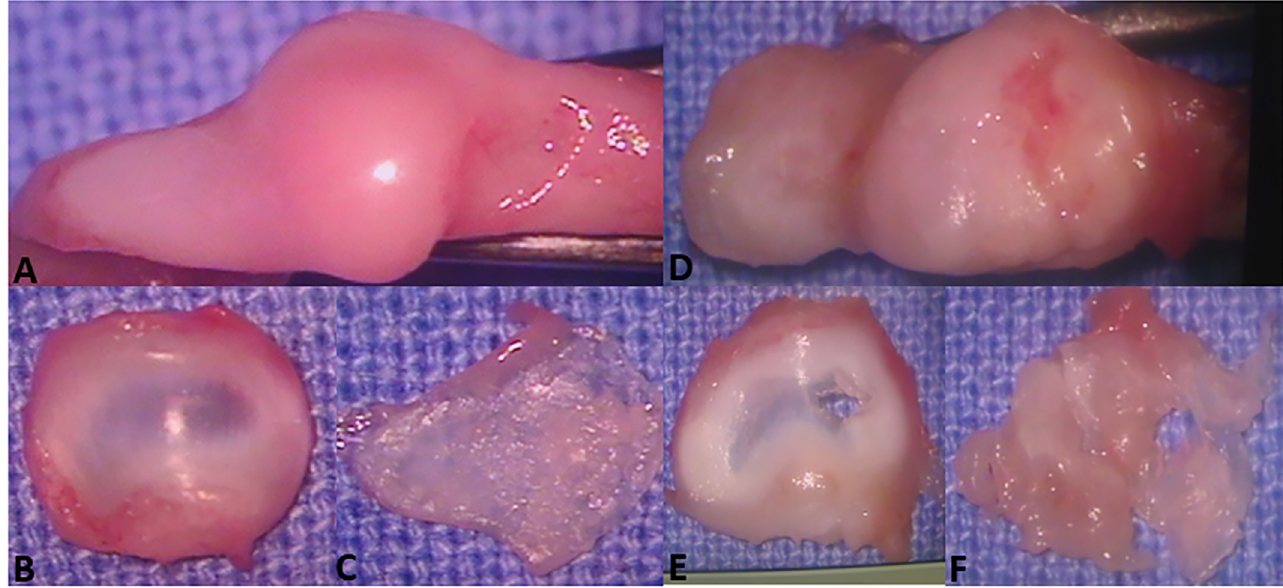
Fig 3. Macroscopic view of temporomandibular joint structures. (A, B, C)—Control group. (A) Condylar surface showing normal convexity and regular contours. (B) Normal disc with characteristic thinning in the central part. (C) Detached condylar cartilage with normal appearance and thickness. Macroscopic view of temporomandibular joint structures. (D, E, F)—Osteoarthritis group. (D) Condylar surface showing erosion, deformation, and flattening. (E) Perforated articular disc. (F) Detached condylar cartilage with perforation and irregularities.